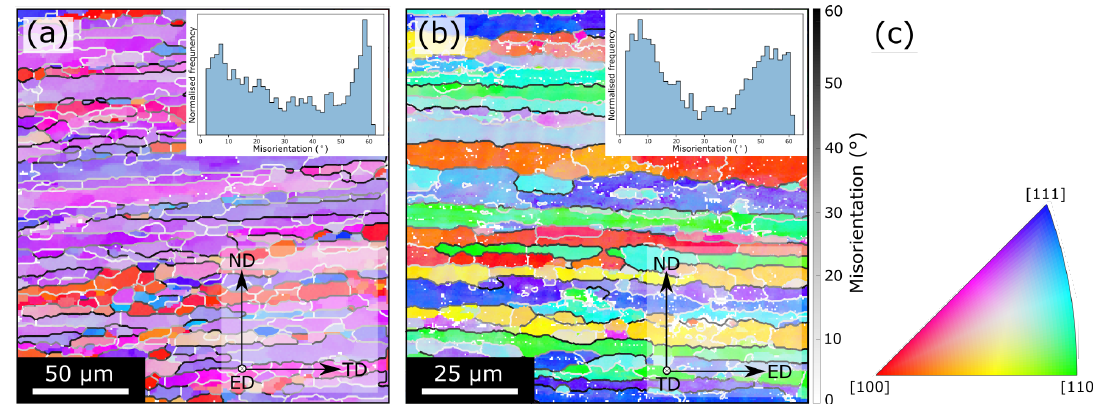
Figure 4. Representative EBSD images acquired along two different directions in ( a , b ). The inset shows the grain boundary misorientation angle vs. frequency. The grains are coloured according to the colour scheme in ( c ). Grain boundary misorientations are colour coded according to the scale in ( b